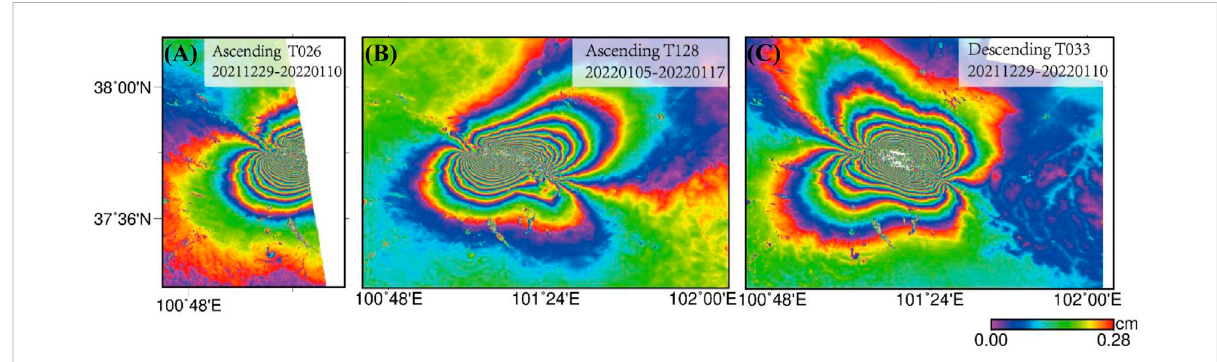
FIGURE 2 Coseismicinterferogramsofthe2022Mw6.7MenyuanearthquakeobservedbyInSAR. (A) Ascendingtrack026, (B) ascendingtrack128,and (C) descending track 033 of the Sentinel-1A.